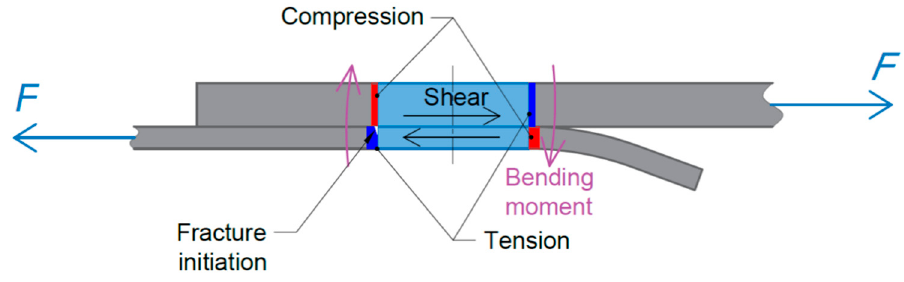
Figure 16. Stresses in a lap joint due to uniaxial tensile force.